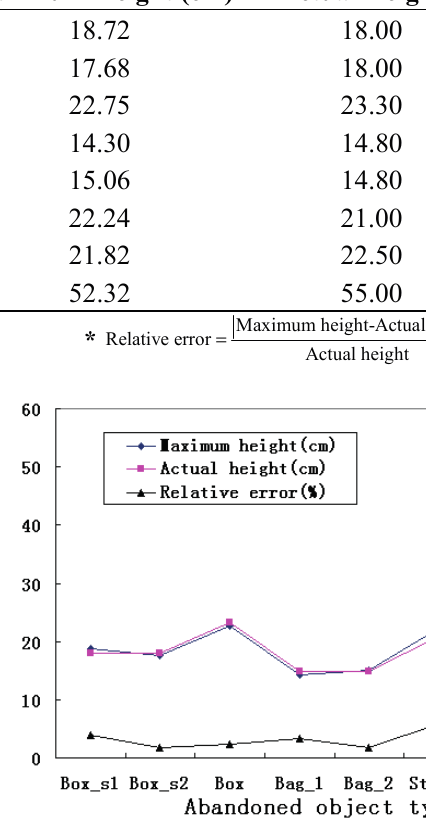
Figure 15. Results of abandoned object detection